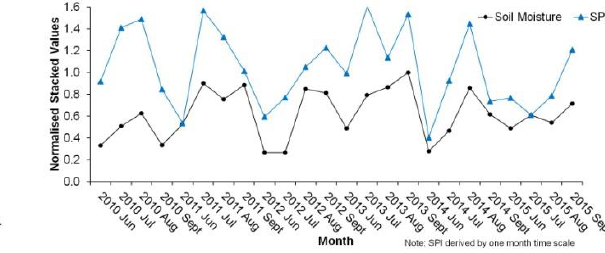
Figure 11. Monthly temporal variation of soil moisture against SPI during Monsoon.